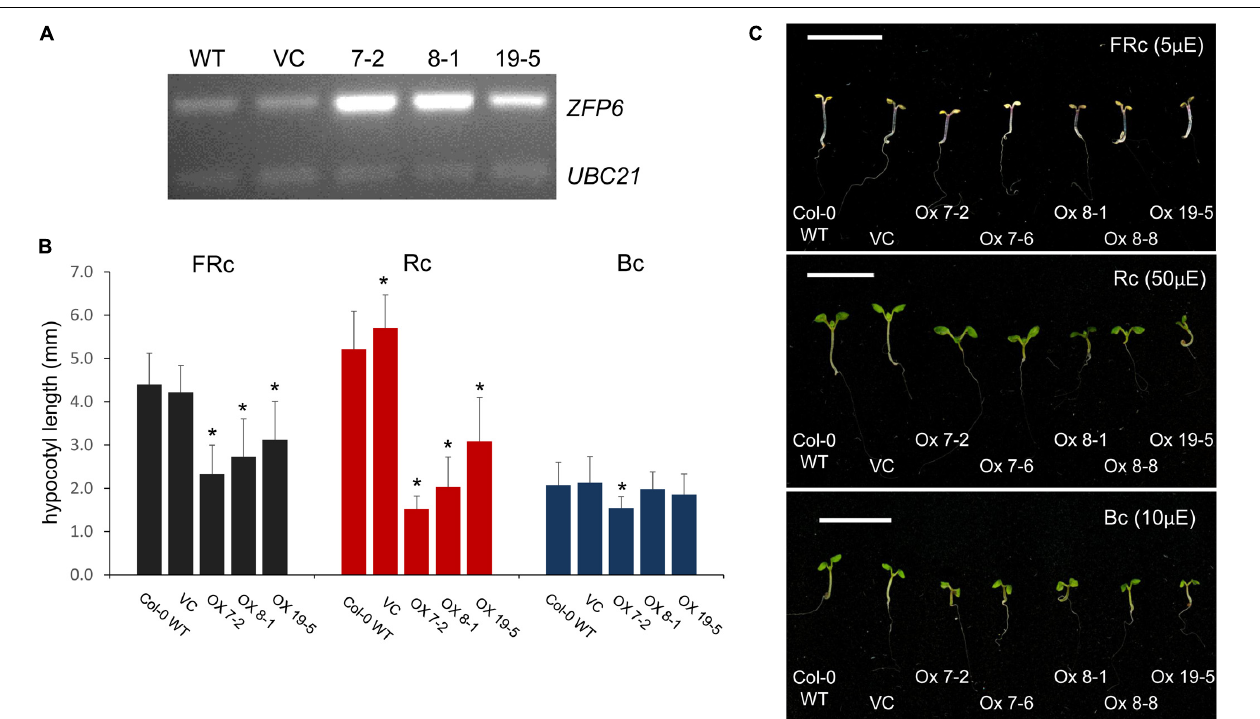
FIGURE 4 | ZFP6 Overexpression and analyses of hypocotyl lengths of seedlings under different light conditions. (A) RT-PCR of ZFP6 mRNA levels relative to control gene UBC21 for wild-type, control lines transformed with an empty vector or vector control (VC), and three independent ZFP6 overexpression lines. (B,C) Seedlings were stratified at 4 ◦ C for 4 days in the dark, grown in MS plates with 1% sucrose, 0.7% agar, and subsequently incubated in different light conditions for 7 days at 22 ◦ C. Seedlings (Col-0 WT, VC lines, and different ZFP6 overexpression (OX) lines (i.e., OX 7-2, OX 7-6, OX 8-1, OX 8-8, and OX 19-5) were grown under continuous far-red (FRc; 5 µ mol m − 2 s − 1 or µ E), red (Rc; 50 µ mol m − 2 s − 1 or µ E), and blue (Bc; 10 µ mol m − 2 s − 1 or µ E) light. (B) Hypocotyl measurements were performed using Image J with at least 25 seedlings per line. Significant differences are shown with asterisks at p ≤ 0.05. (C) Representative images of seedlings are shown. Bar, 1 cm.